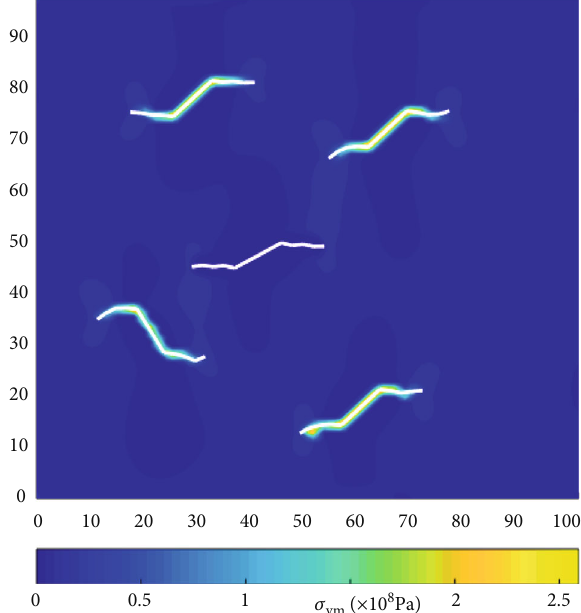
Figure 13: Shaded plots of the von Mises stress σ vm for the multiple-crack example, case 2, for an increased propagation (lengths in